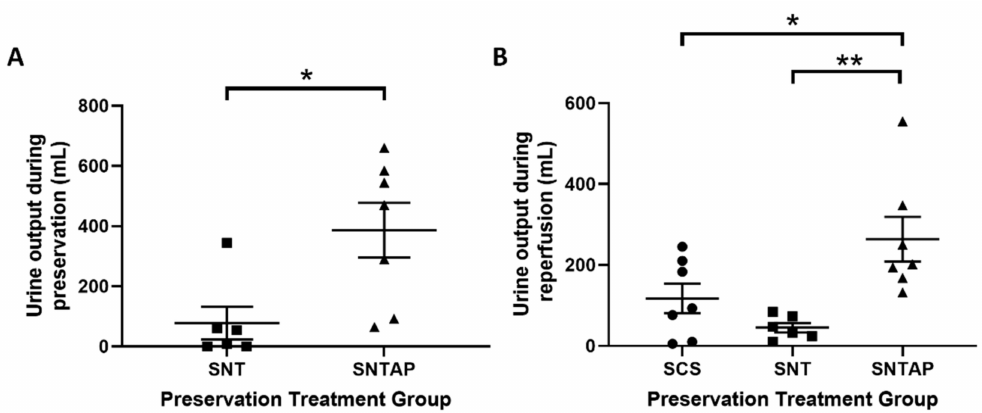
Figure 2. Subnormothermic perfusion with AP39 improves urine output during preservation and reperfusion. Porcine kidneys were nephrectomized after 30 min of clamping to mimic donation after cardiac death (DCD) injury and subjected to various preservation treatments for 4 h. This was followed by 4 h of reperfusion with stressed autologous blood. Urine output was collected during both perfusion periods for all groups, except for the static cold storage group, where kidneys were on ice during the 4 h of preservation. ( A ) Total urine output (mL) collected during 4 h of preservation perfusion. ( B ) Total urine output (mL) collected during 4 h of reperfusion with stressed blood. Lines represent mean ± SEM. Values in ( A ) were compared using a student’s unpaired t -test, and values in ( B ) were compared using one-way ANOVA followed by Tukey’s post-hoc test. * p < 0.05 and ** p < 0.01. Circles represent values for static cold storage (SCS, n = 7). Squares represent values for subnormothermic perfusion (SNT, n = 6). Triangles represent values for subnormothermic perfusion with 200 nM AP39 (SNTAP, n =